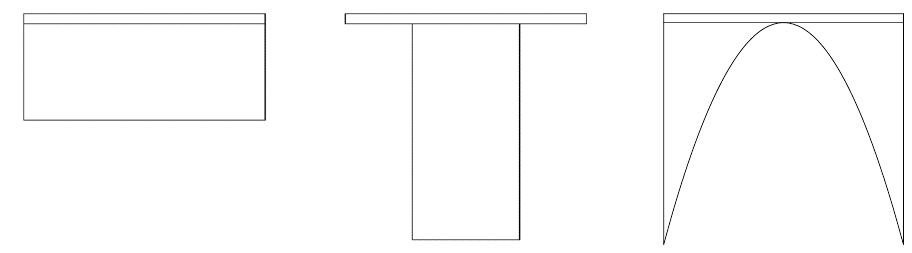
Figure 2. Three golf putter head configurations all with identical 5 mm face, body mass evenly distributed ( left ), located centrally ( middle ) & peripherally ( right